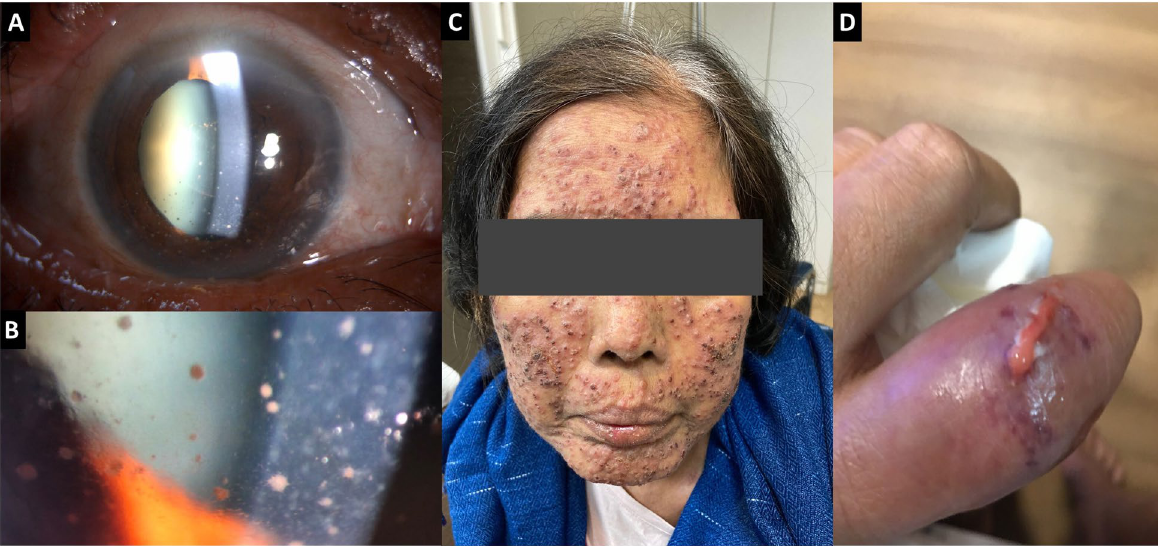
Fig. 1 Slit-lamp photograph of the right eye ( A ), higher magnification ( B ) showing diffuse granulomatous keratic precipitates predominantly at the inferior cornea. Clinical photograph of the face ( C ) showing multiple diffuse erythematous papules with vesicles. Clinical photograph of the left index finger ( D ) showing swollen soft tissue and pus discharge